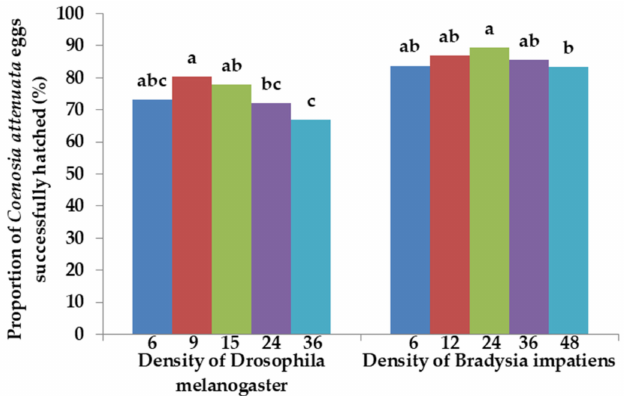
Figure 6. Proportion of eggs successfully hatched for C. attenuata when fed 6, 9, 15, 24 and 36 adults of D. melanogaster and 6, 12, 24, 36 and 48 adults of B. impatiens daily per predator adult.